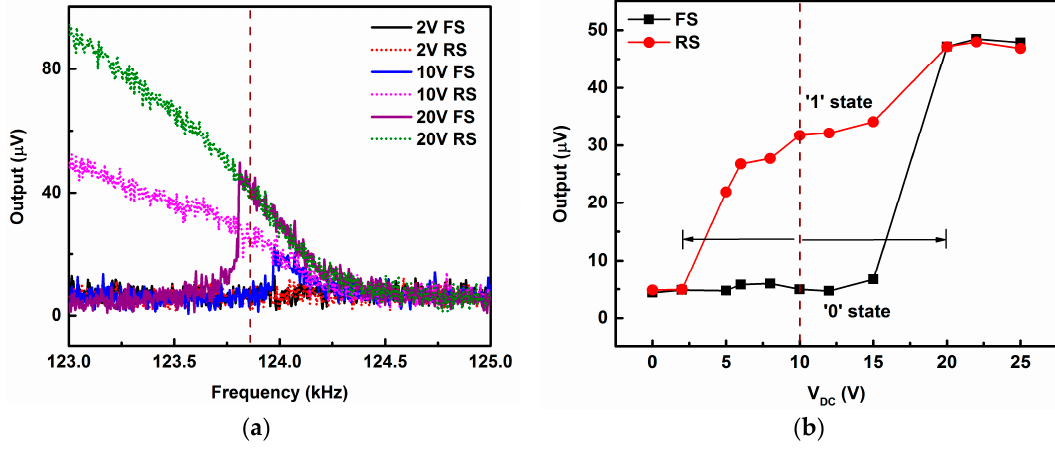
Figure 3. ( a ) Experimentally obtained frequency–response curves at different applied DC bias voltages while alternating current (AC) voltage is fixed at − 5 dBm (0.125 V rms ). Forward and backward sweeps (FS/BS) were performed to observe the frequency hysteresis cycle. Forward sweeps for all DC bias voltages are shown in solid lines, whereas the backward sweep curves are shown in dotted lines; ( b ) Response of the resonator with respect to the DC bias voltage at a fixed frequency (123.863 kHz) and fixed AC voltage ( − 5 dBm). The response shows a hysteretic behavior when the DC bias voltage is swept in forward (black line with square symbols) and backward directions (red line with circle symbols). The chosen operating point at 10 V, which has two states (“1” or “0”), and can be set or reset to memory states by momentarily increasing or decreasing the DC bias voltage, respectively.